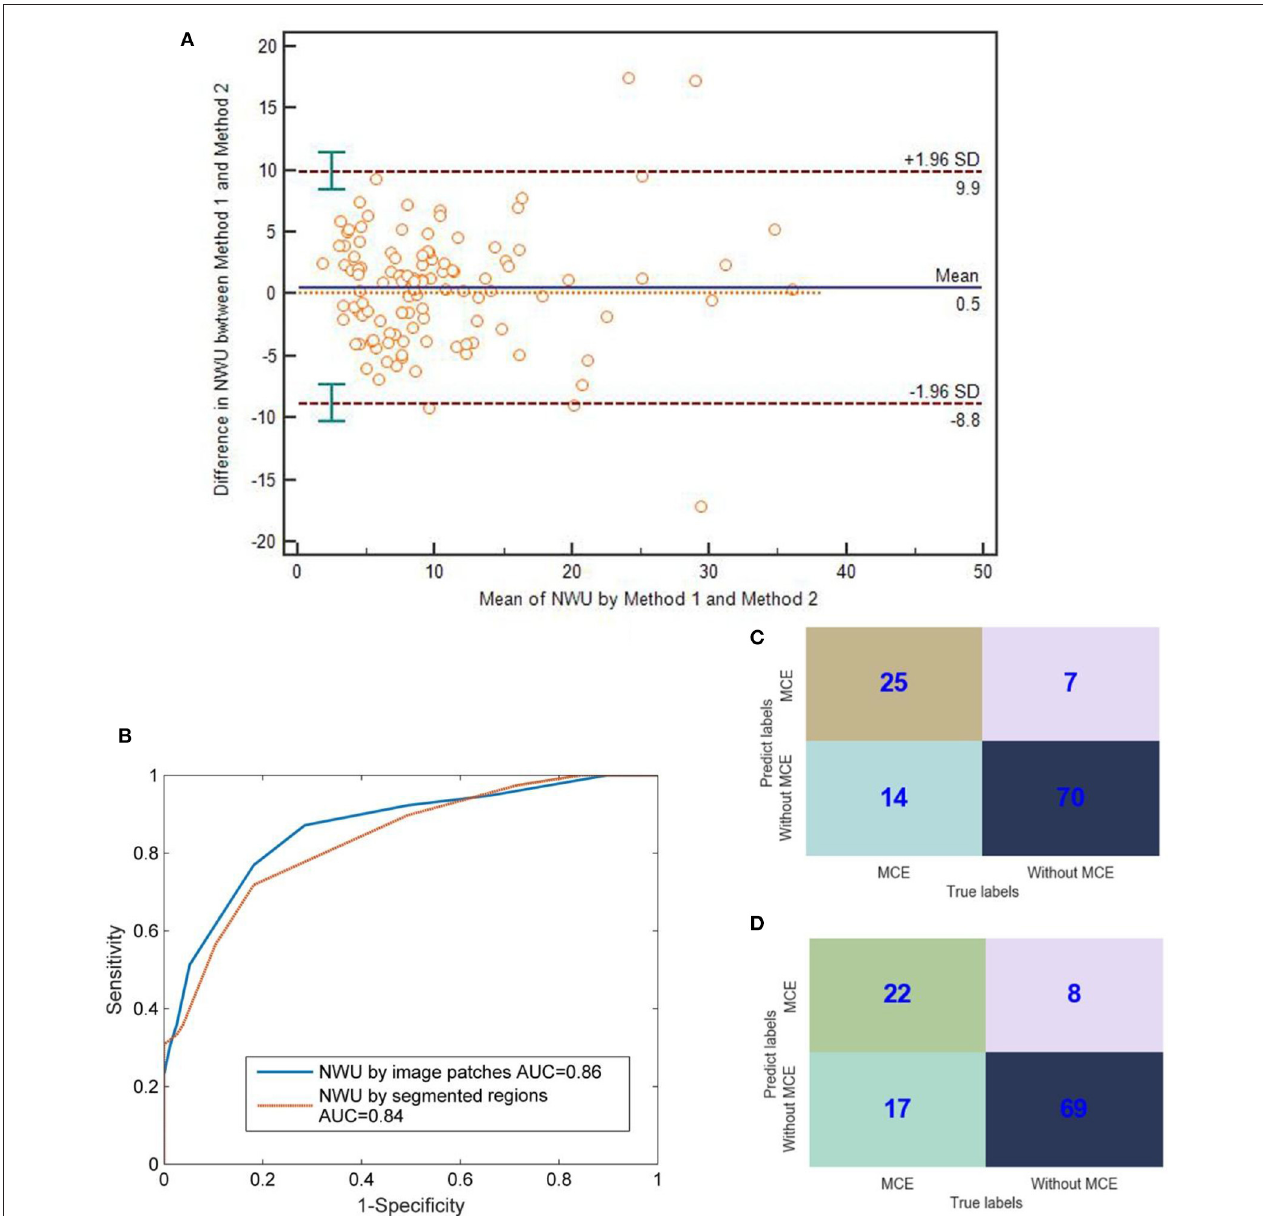
FIGURE 5 | Comparison between IP-NWU and SR-NWU and their predictive performances for malignant cerebral edema (MCE). (A) Consistence of IP-NWU and SR-NWU; (B) ROC curves of MCE prediction by IP-NWU and SR-NWU; (C) The confusion matrix of MCE prediction by IP-NWU; (D) The confusion matrix of MCE prediction by